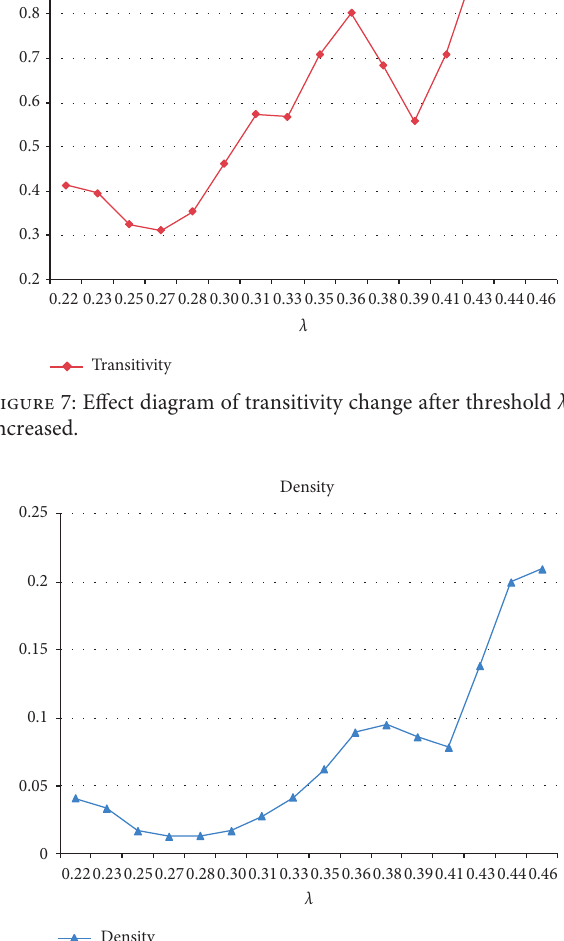
Figure 8: Effect diagram of density change after threshold λ is increased.